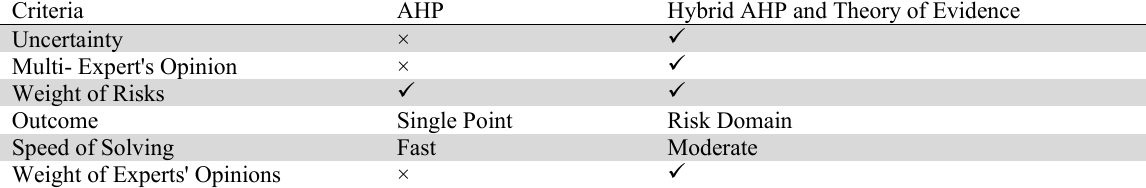
Comparing Classic AHP and the Proposed Hybrid AHP and Dempster-Shafer Theory of Evidence